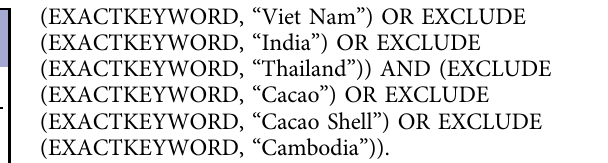
Fig. 1 The PRISMA 2020 fl ow diagram for this systematic review. Our initial result of 3846 documents (results as of 14 November 2021) was fi ltered by including only peer-reviewed, full-text English articles on rice, resulting in 2243 eligible documents.